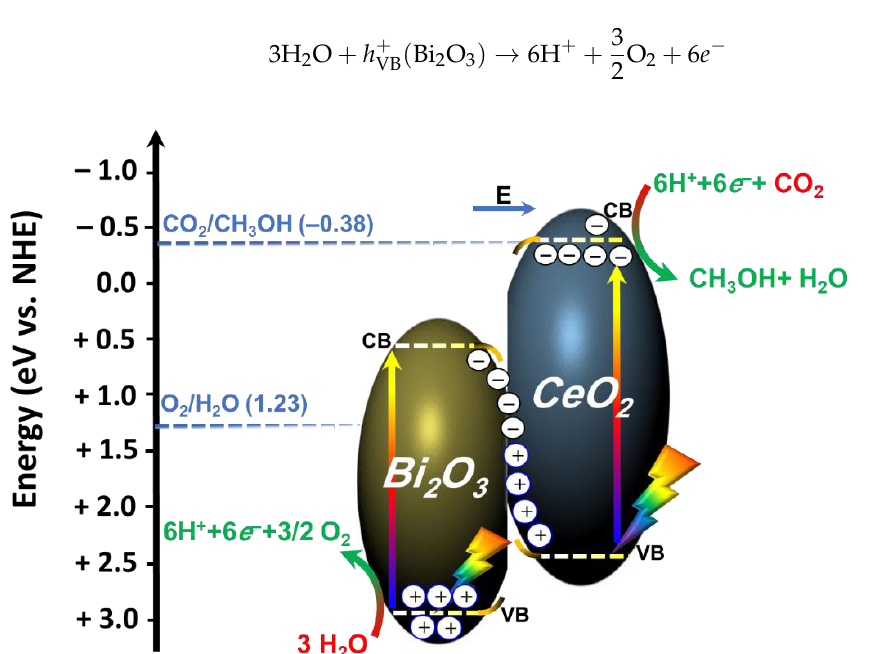
Figure 9. Estimated band diagrams, charge transfer, and photocatalytic pathway for CO 2 conversion into methanol over optimized Bi 2 O 3 /CeO 2 heterojunctions.